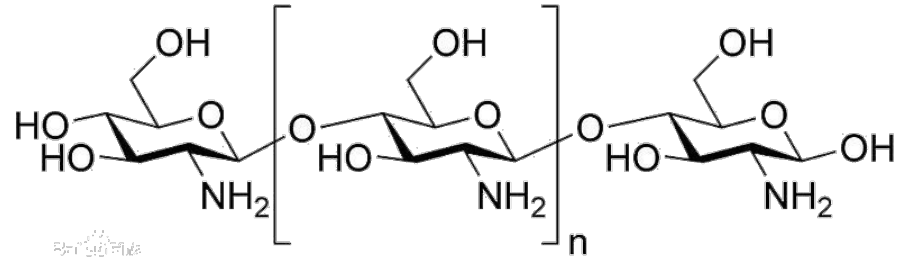
Figure 6. Chemical structure of chitosan.